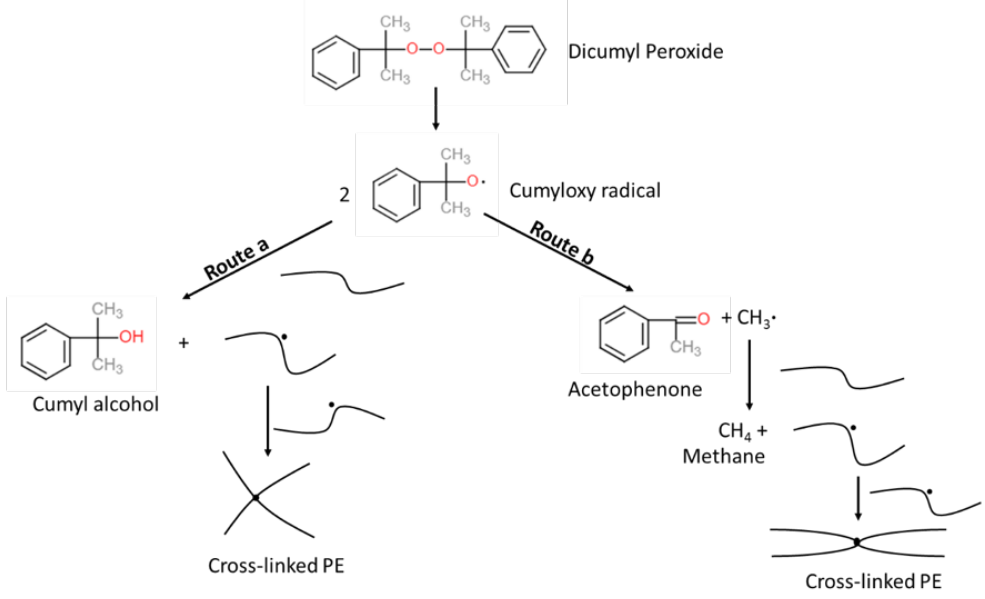
Figure 1. Dicumyl peroxide (DCP)-initiated polyethylene (PE) cross-linking reaction scheme compiled from Andrews et al. [1] and Sun et al.